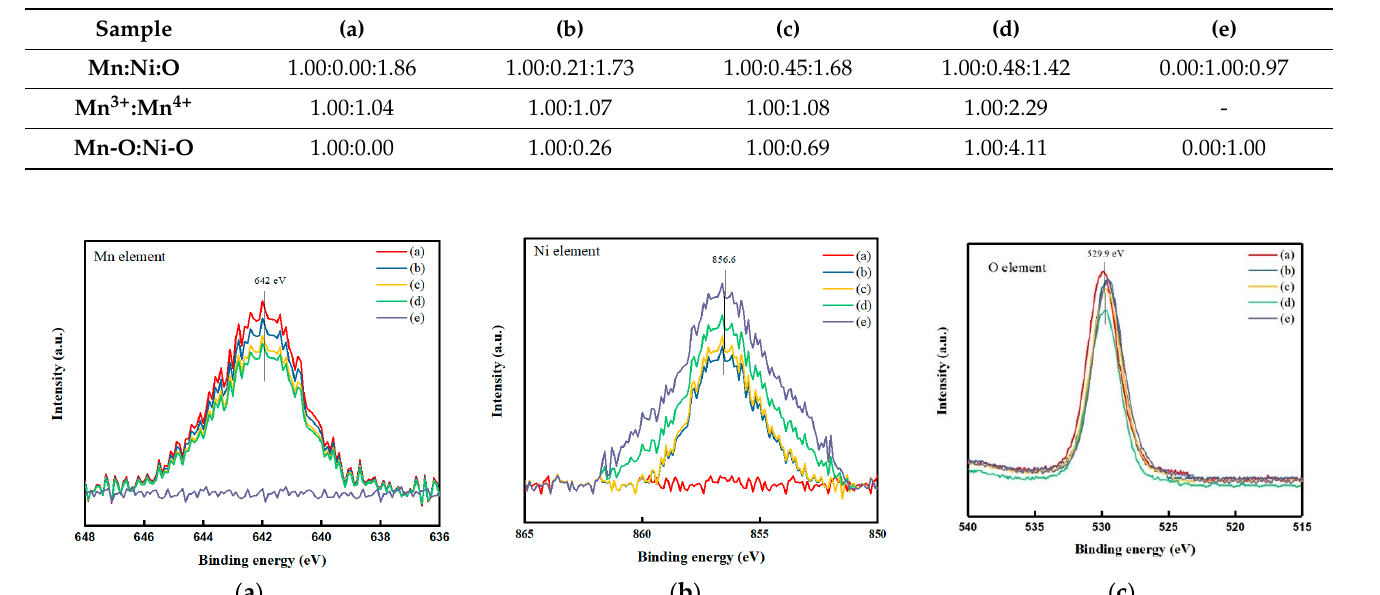
Table 2. XPS elemental and compositional ratios. Samples (a), (b), (c), (d) and (e) denote the samples with electroplating